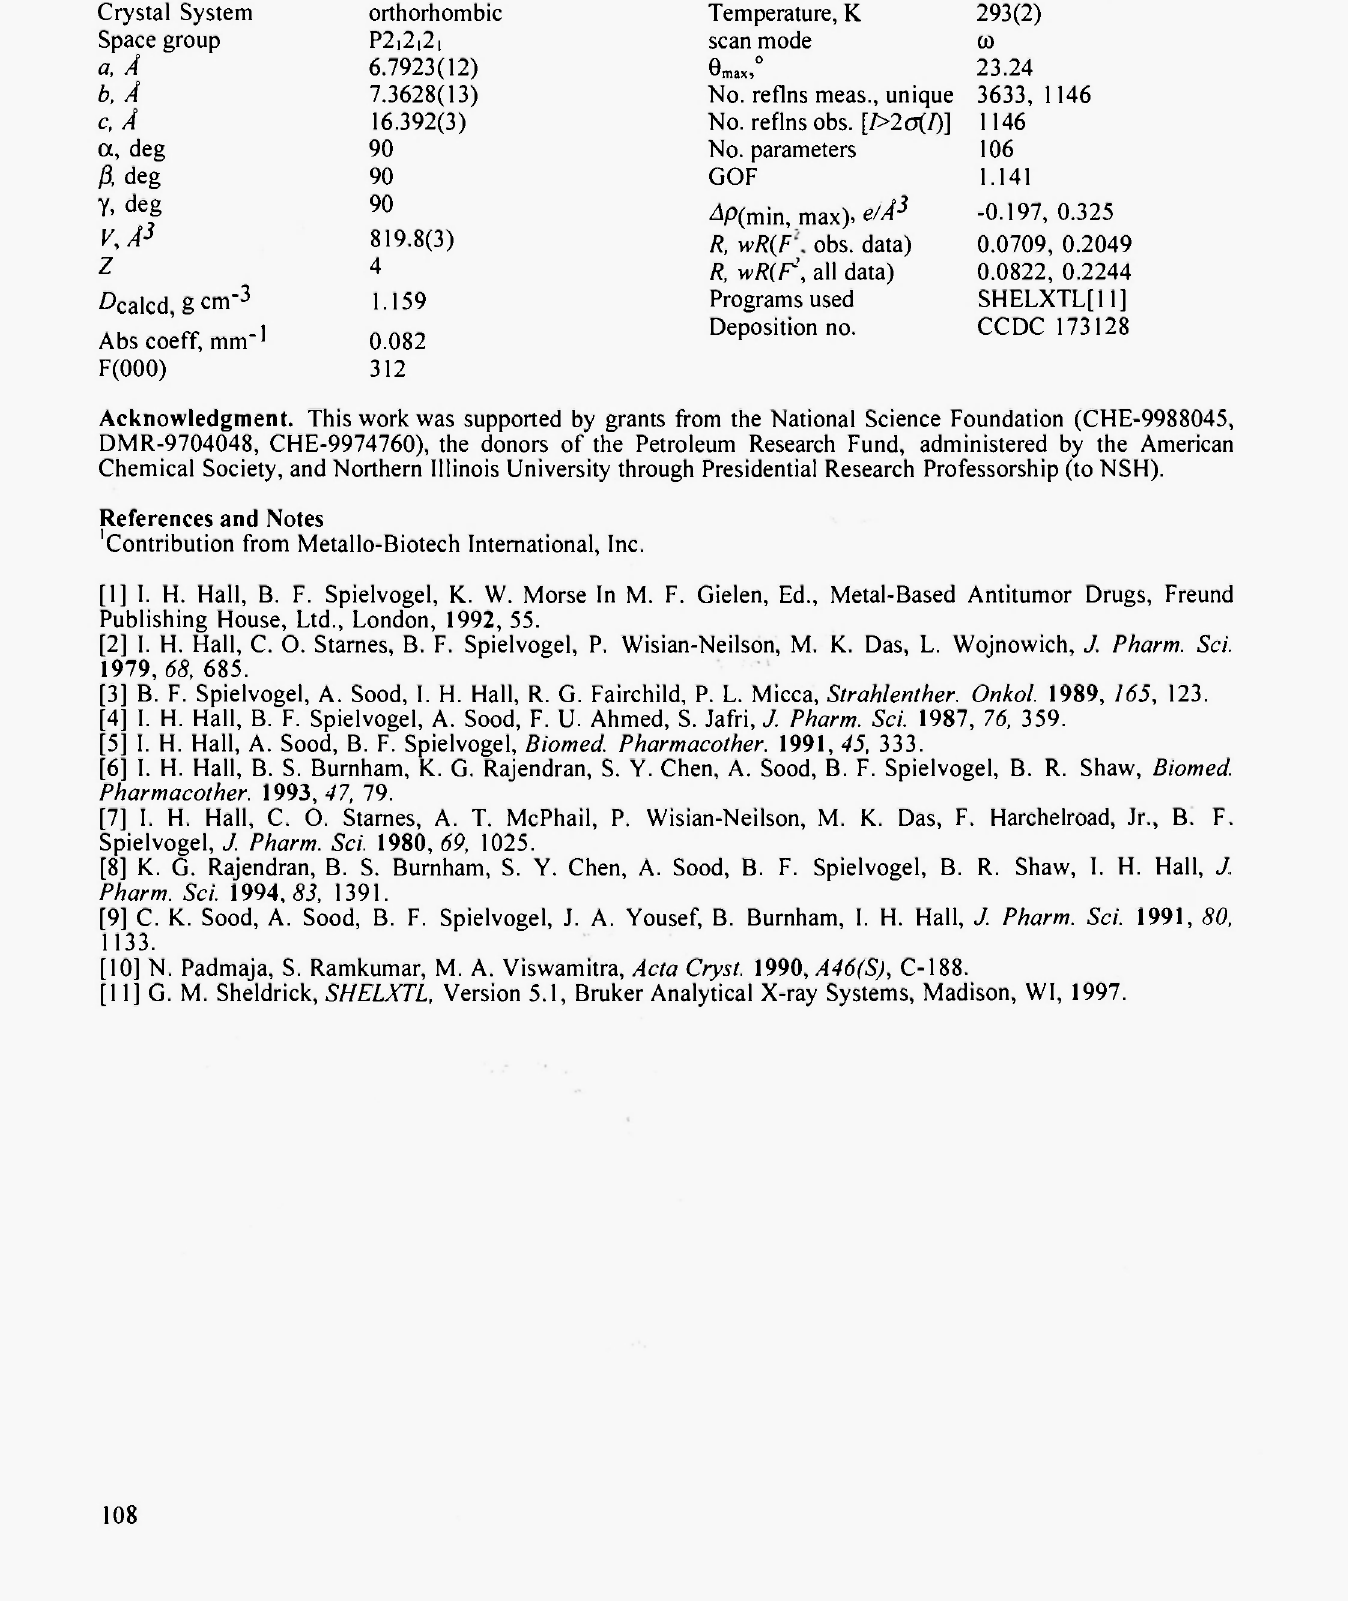
Table 1. Crvstallographic Data for piperidinecarboxyborane